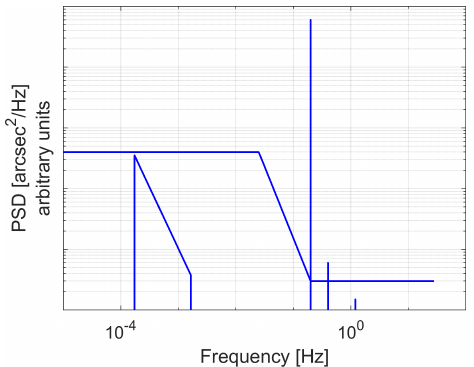
Figure 10. Conceptual model of the azimuth absolute knowledge error PSD. Contributions from different mechanisms are expected in different regions of the spectrum. For instance, sharp peaks are expected in correspondence to the scan